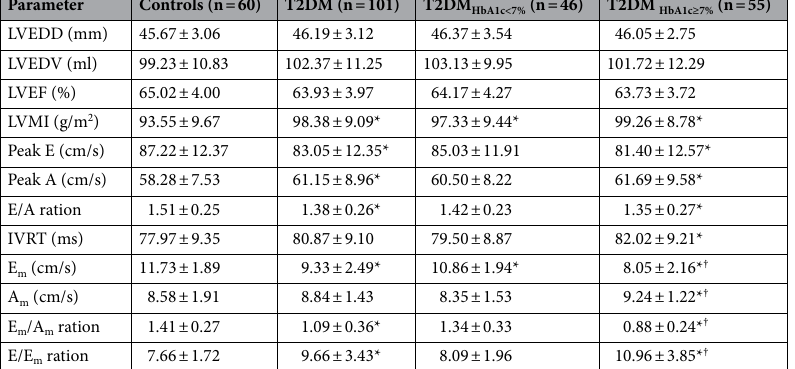
Table 2. Routine echocardiographic characteristics. Data are represented as the mean ± SD. LVEDD left ventricular end diastolic diameter, LVEDV left ventricular end diastolic volume, LVEF left ventricular